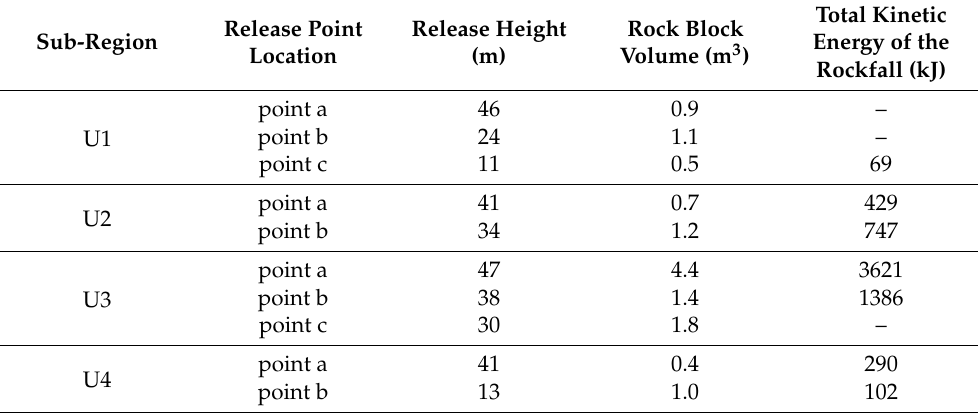
Table 5. The exports from the trajectometry simulations, executed by RocFall